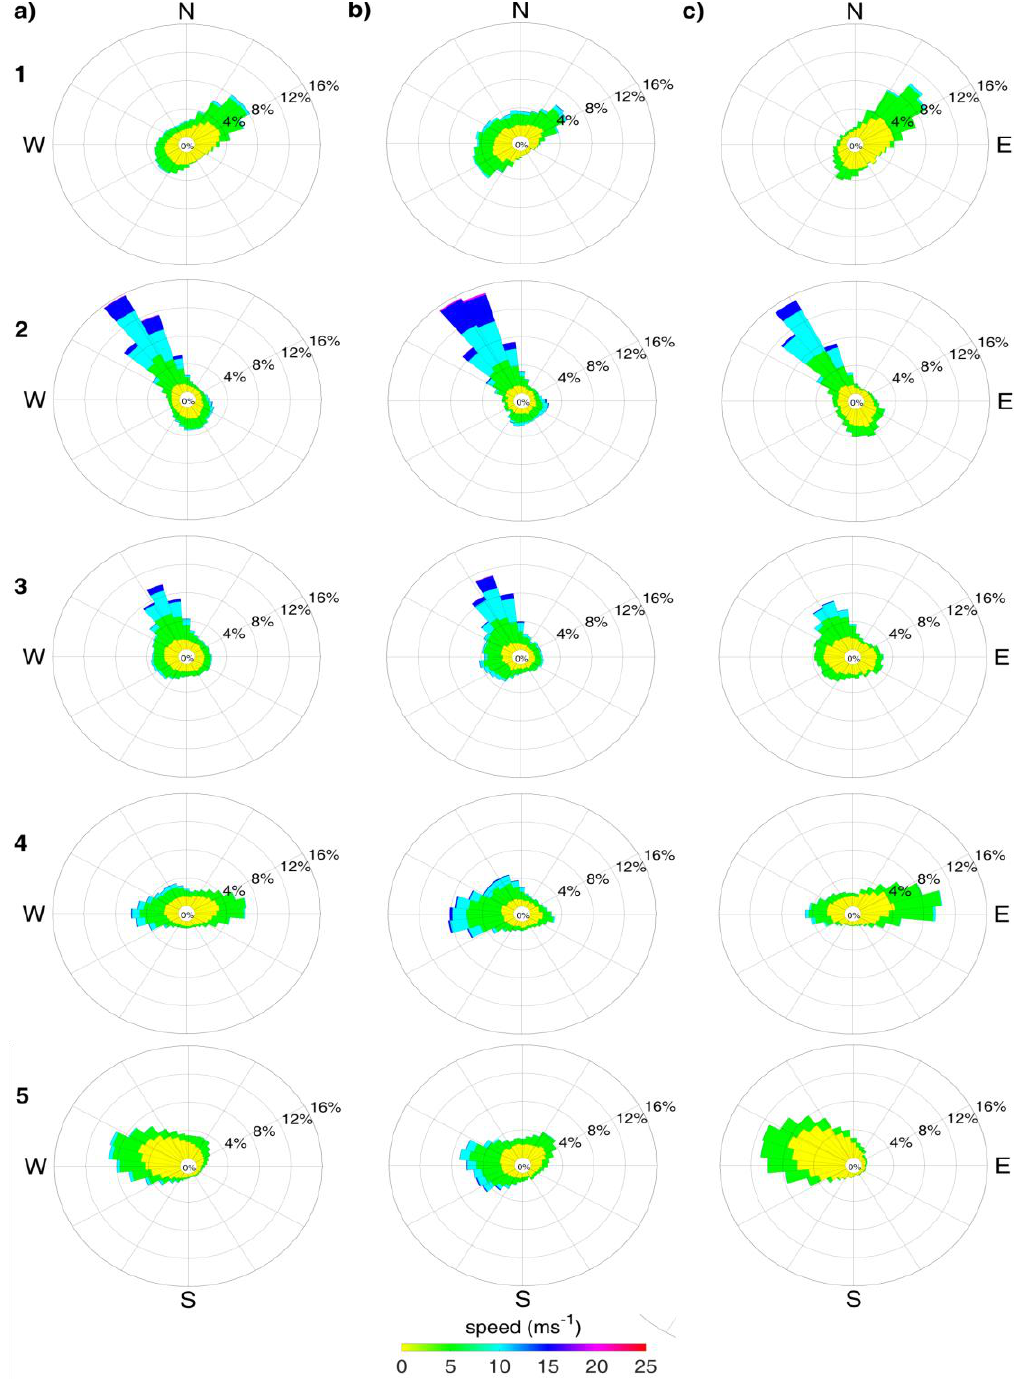
Figure 7. Wind roses based on the ERA Interim data set (1982–2017): columns ( a – c ) represent full years, January-February and May-June time intervals, respectively. Row numbers (1–5) correspond to 5 locations indicated in Figure 4a.